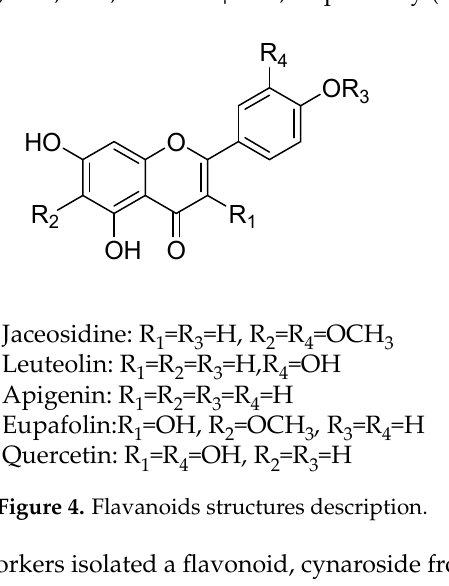
Figure 4. Flavanoids structures description.